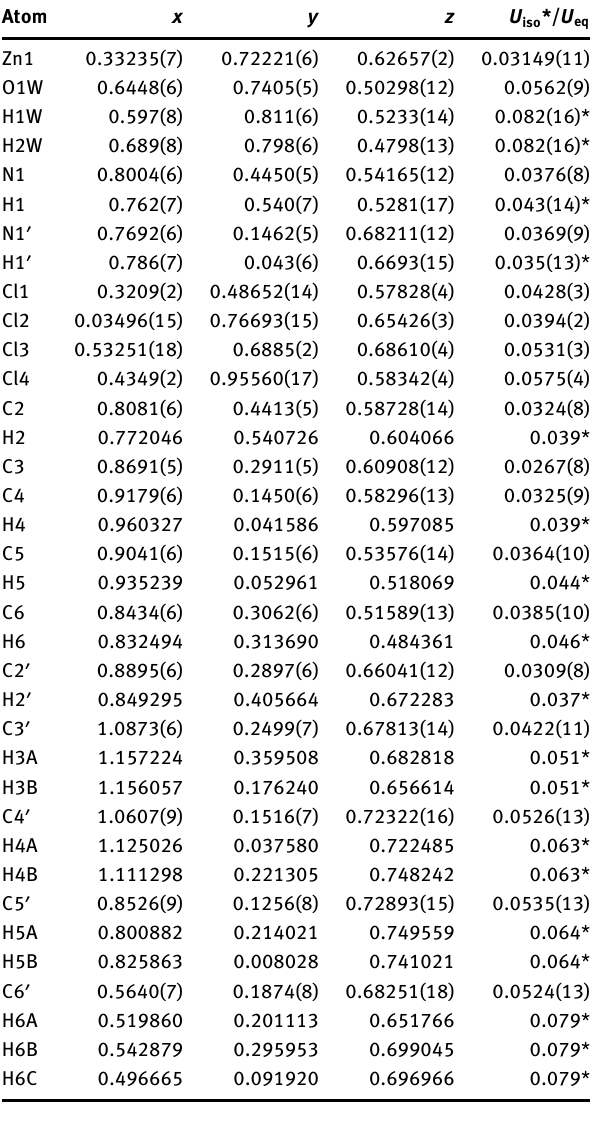
Table 2: Fractional atomic coordinates and isotropic or equivalent isotropic displacement parameters (Å 2